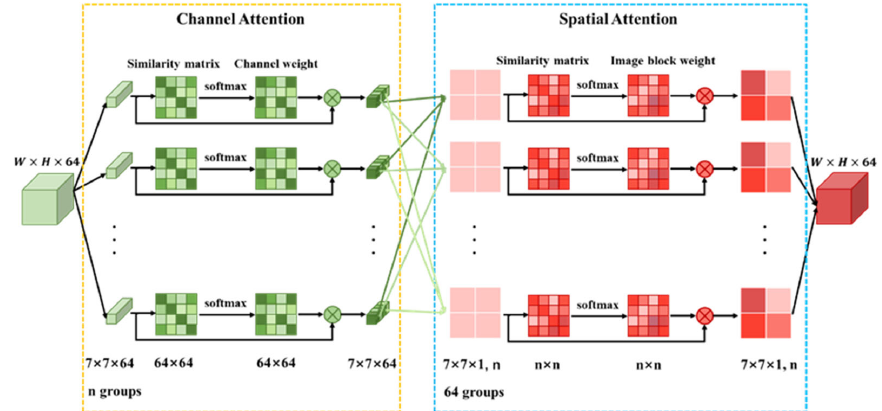
Figure 3. The detail architecture of CSAS.